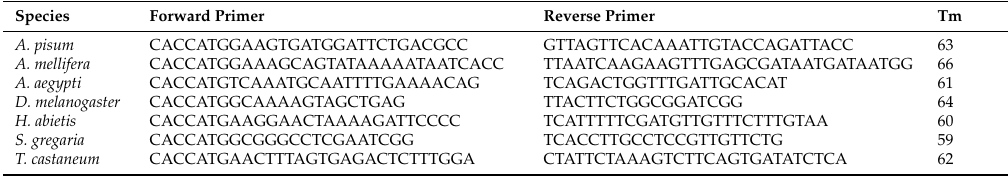
Table 2. Sequences of the primers used in this study to pick-up the adipokinetic hormone receptors of the specified insects. Note that we added a CACC sequence in front of each forward primer to obtain a kozak sequence necessary for expression in vertebrate cell lines. Primer specific annealing temperatures (Tm: melting temperature) are indicated in degrees